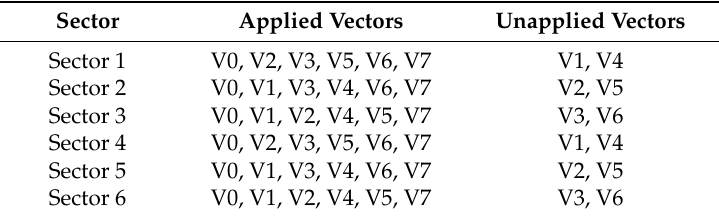
Table 2. Applied and unapplied voltage vectors.